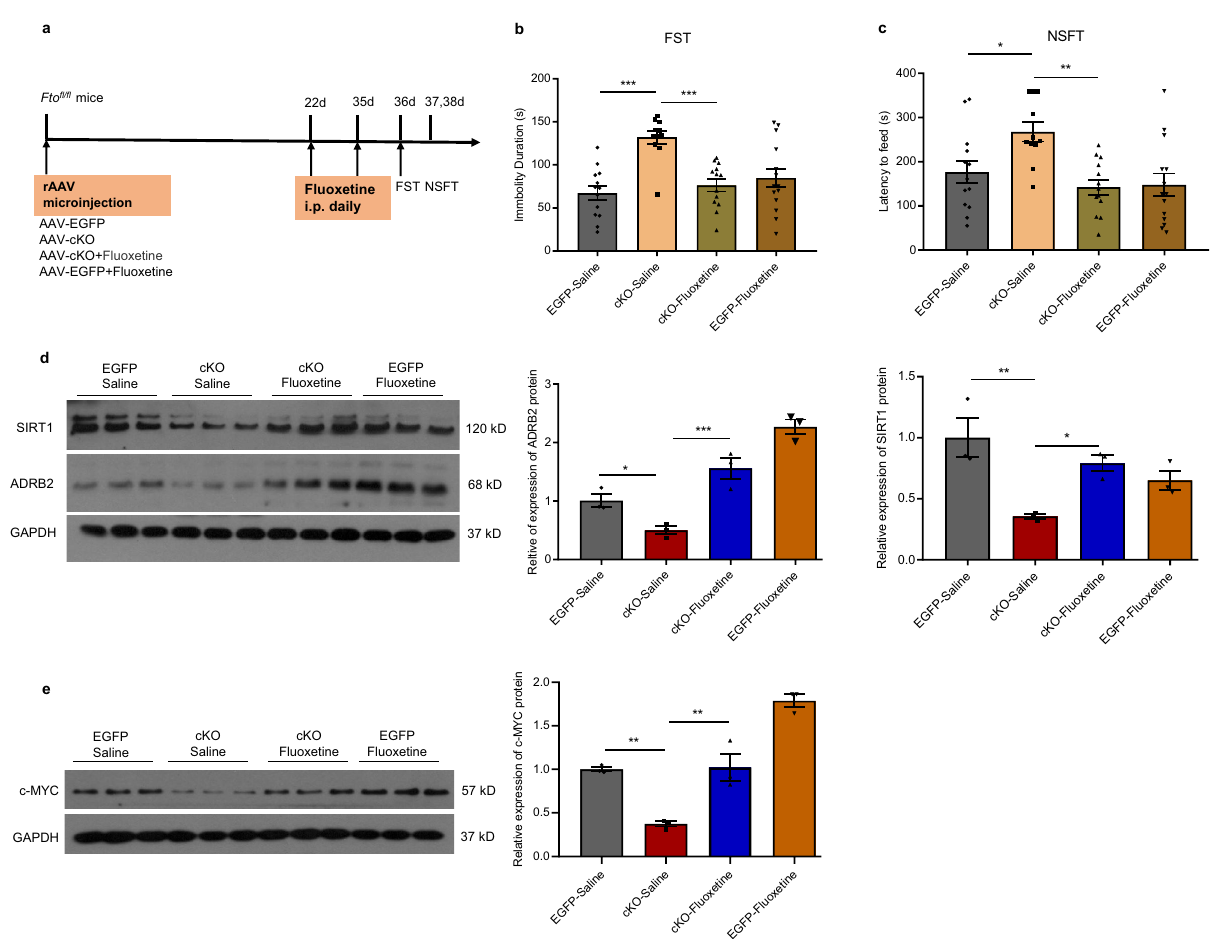
Fig. 6 Fluoxetine rescues depression-like behaviors and ADRB2/c-MYC/SIRT1 protein expression induced by hippocampal FT O de fi ciency. a Schematics of the experimental design. b , c FST and NSFT after treatment with fl uoxetine. EGFP-Saline, n = 13; cKO-Saline, n = 11; cKO + Fluoxetine, n = 13; EGFP- Fluoxetine, n = 14. b EGFP-Saline vs. cKO-Saline, p < 0.0001; cKO-Saline vs. Cko + Fluoxetine, p = 0.0001. c EGFP-Saline vs. cKO-Saline, p = 0.0187; cKO-Saline vs. Cko + Fluoxetine, p = 0.0011. d , e SIRT1, ADRB2 and c-MYC expression in the hippocampus of Fto -cKO mice treated with fl uoxetine, n = 3 per group. d ADRB2, EGFP-Saline vs. cKO-Saline, p = 0.0481; cKO-Saline vs. cKO + Fluoxetine, p = 0.0008. SIRT1, EGFP-Saline vs. cKO- Saline, p = 0.0028; cKO-Saline vs. cKO + Fluoxetine, p = 0.0239. e EGFP-Saline vs. cKO-Saline, p = 0.0021; cKO-Saline vs. cKO + Fluoxetine, p = 0.0016. * p < 0.05, ** p < 0.01, *** p < 0.001. Statistical signi fi cance was calculated using one-way ANOVA and adjustments were made for multiple comparisons test. Source data are provided as a Source Data fi